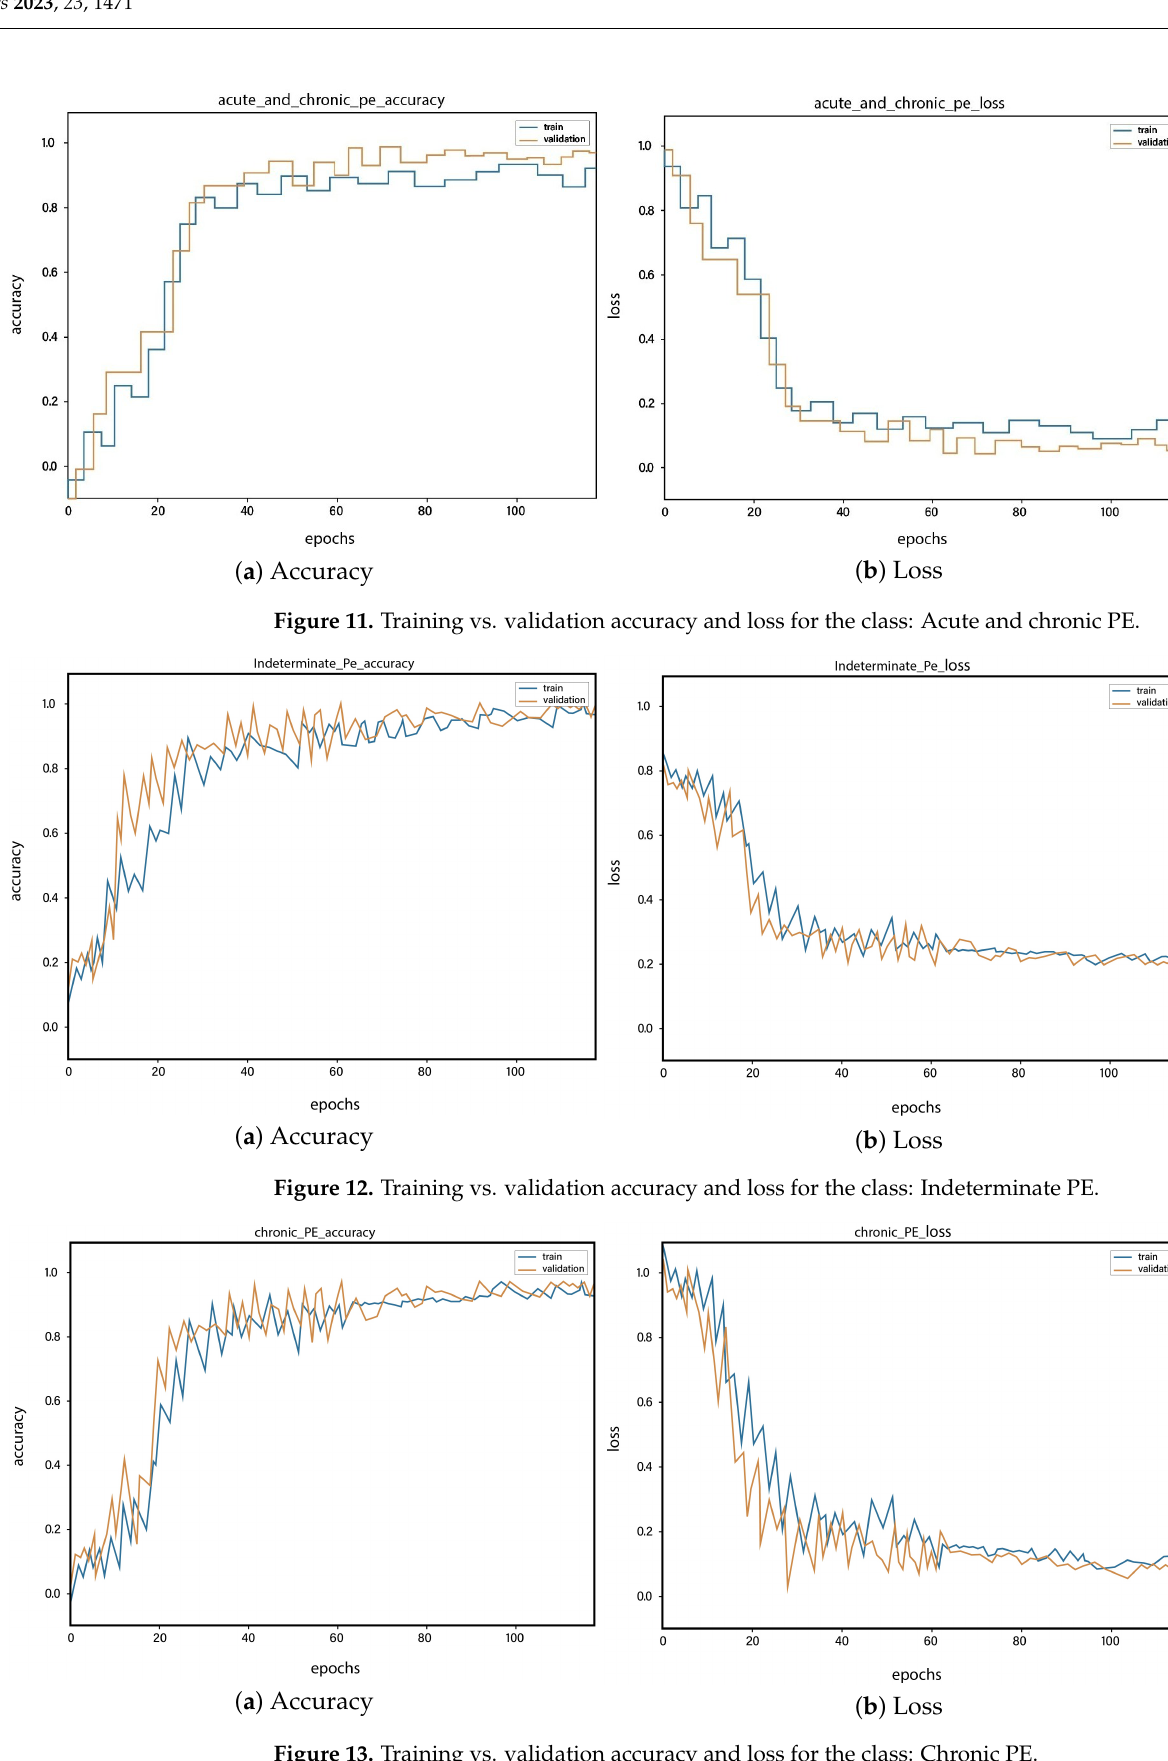
Figure 13. Training vs. validation accuracy and loss for the class: Chronic